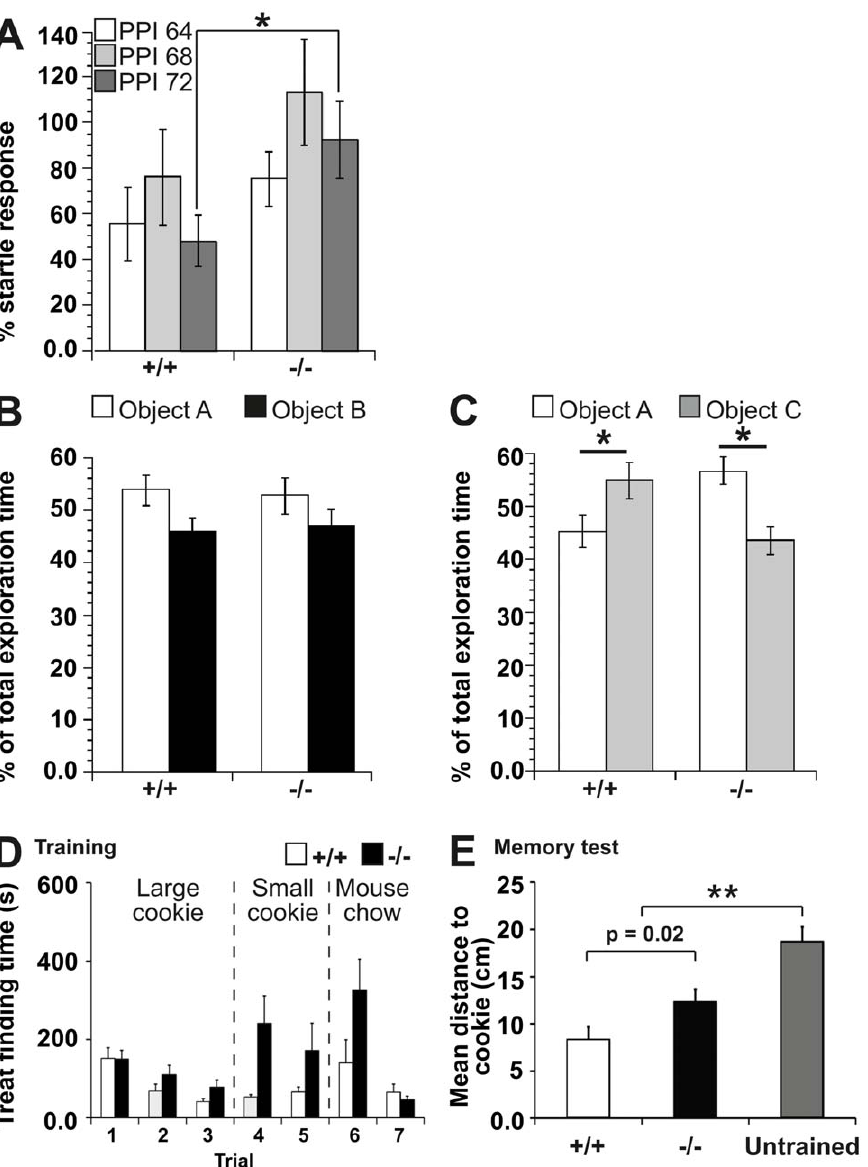
Figure 4. Upregulation of metabotropic glutamate receptor 4 in Panx1 2 / 2 mice. a, Volcano plot representing the expression of 84 genes relevant for synaptic plasticity (Panx1 + / + /Panx1 2 / 2 , n=4). b, Inhibition of grm4 by bath application of 100 m M UBP1112. Fifteen minutes post-HFS, UBP1112 induced impaired persistent LTP in Panx1 2 / 2 s. Panx1 + / + -LTP steadily increased during the entire post-HFS period without reaching the level of untreated Panx1 2 / 2 s. Insets in (b) indicate Panx1 2 / 2 and Panx1 + / + original responses under blocking conditions before and 30 min post-HFS (scale horizontal: 10 ms, vertical: 0.5 mV). c, No differences were found for Panx1 2 / 2 s during the early LTP phase (0–5 min) compared to the ACSF treated Panx1 2 / 2 s. Persistent phase analysis reveals alignment of the fEPSP levels of both the UBP1112-treated + / + and 2 / 2 . Statistics: (c) ANOVA (early: F3,64 =637.1; P , 0.0001; late: F3,64 =105.9; P , 0.0001).